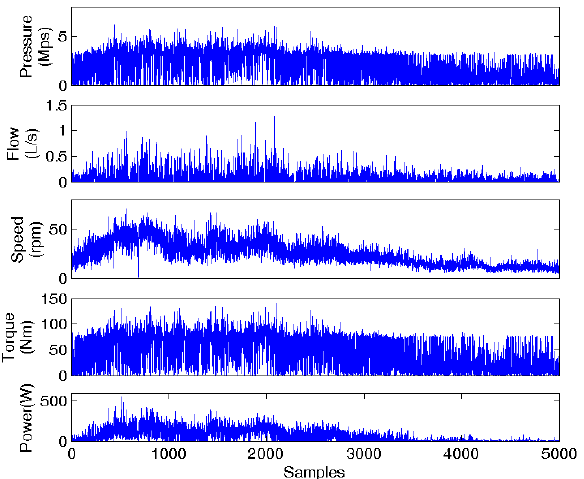
Figure 3. Examples of pre-processed data measured from the WEC.